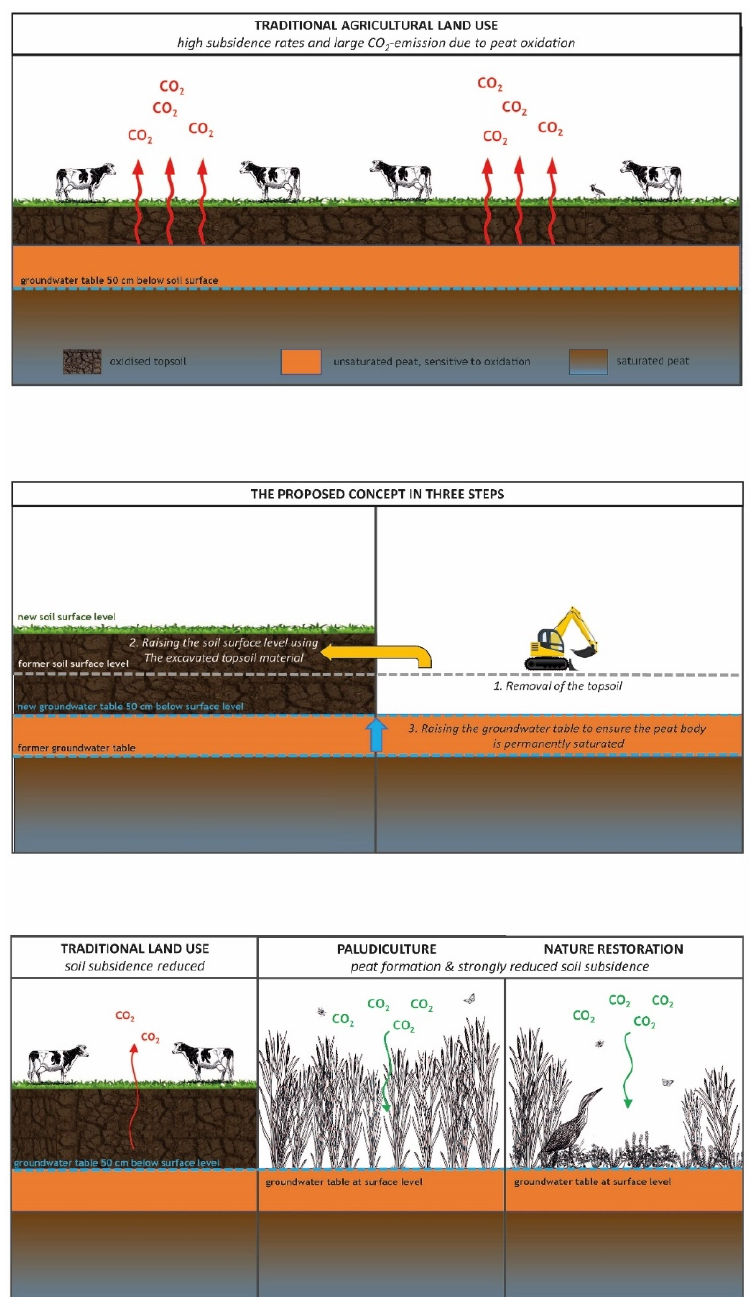
Figure 4. Schematic representation of the proposed concept of topsoil replacement before rewetting during the transition period towards a more sustainable use of coastal peat areas. Upper panel: traditional drainage- based agricultural land use in peat meadows. The groundwater table is usually situated below the intact peat soil which causes severe soil subsidence and high CO 2 -emission. Middle panel: overview of three steps: (1) removal of the nutrient-rich topsoil in area X, (2) raising the soil surface level using the excavated topsoil material in area Y, and (3) raising the groundwater table to ensure the intact peat soil is permanently saturated in both area X and Y. Lower panel: in the new situation the higher groundwater table will facilitate the implementation of more sustainable measures such as nature restoration or paludiculture in area X, but area Y will also remain suitable for continuation of traditional agricultural land use. The thicker unsaturated topsoil in area Y mainly consists of recalcitrant, already oxidised material which has become insensitive to peat oxidation. As the sensitive, intact subsoil in area X will become permanently saturated, the overall expectation is that our proposed concept of topsoil replacement before rewetting will strongly reduce soil subsidence and CO 2 -emissions (from: Smolders et al . 2019, created by Bas van de